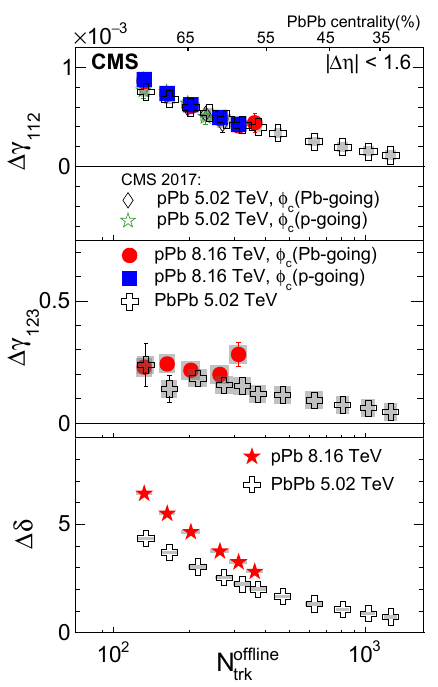
Figure 2. The SS and OS three-particle correlators, γ 112 (upper) and γ 123 (middle), and two-particle correlator, Figure 3. The di ff erence of the OS and SS three-particle correlators, γ 112 (upper) and γ 123 (middle), and two- δ (lower), averaged over < 1 . 6 as a function of N o ffl ine ∆ η = 8 . 16 TeV and PbPb particle correlator, δ (lower), averaged over in pPb collisions at √ s trk NN | | collisions at 5.02 TeV [14]. The SS and OS two-particle correlators are denoted by di ff erent markers for pPb TeV and PbPb collisions at 5.02 TeV [14]. The pPb results are obtained with particle c from Pb- and p-going collisions. The results of γ 112 for pPb collisions at 5.02 TeV from CMS Collaboration (CMS 2017 [13]), are also sides separately. The ∆ δ correlator is denoted by a di ff erent marker for pPb collisions. The results of γ 112 for pPb shown for comparison. Statistical and systematic uncertainties are indicated by the error bars and shaded regions, collisions at 5.02 TeV from CMS Collaboration (CMS 2017 [13]), are also shown for comparison. Statistical and respectively. systematic uncertainties are indicated by the error bars and shaded regions,